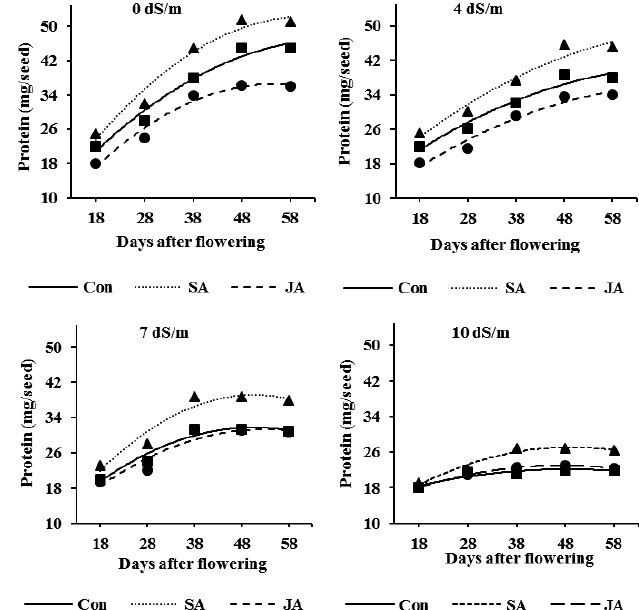
Fig. 5: Protein yields of soybean seeds per plant under different salinity and hormonal treatments Different letters indicate significant difference at p ≤